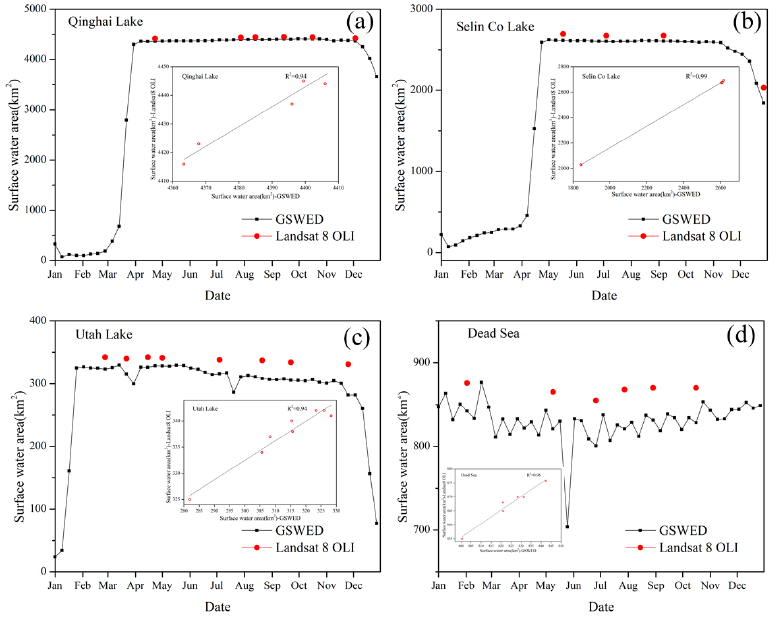
Figure 5. Validation of global surface water extent dataset in 2015 in Qinghai Lake ( a ), Selin Co Lake ( b ), Utah Lake ( c ), and Dead Sea ( d ) using Landsat 8 OLI images.